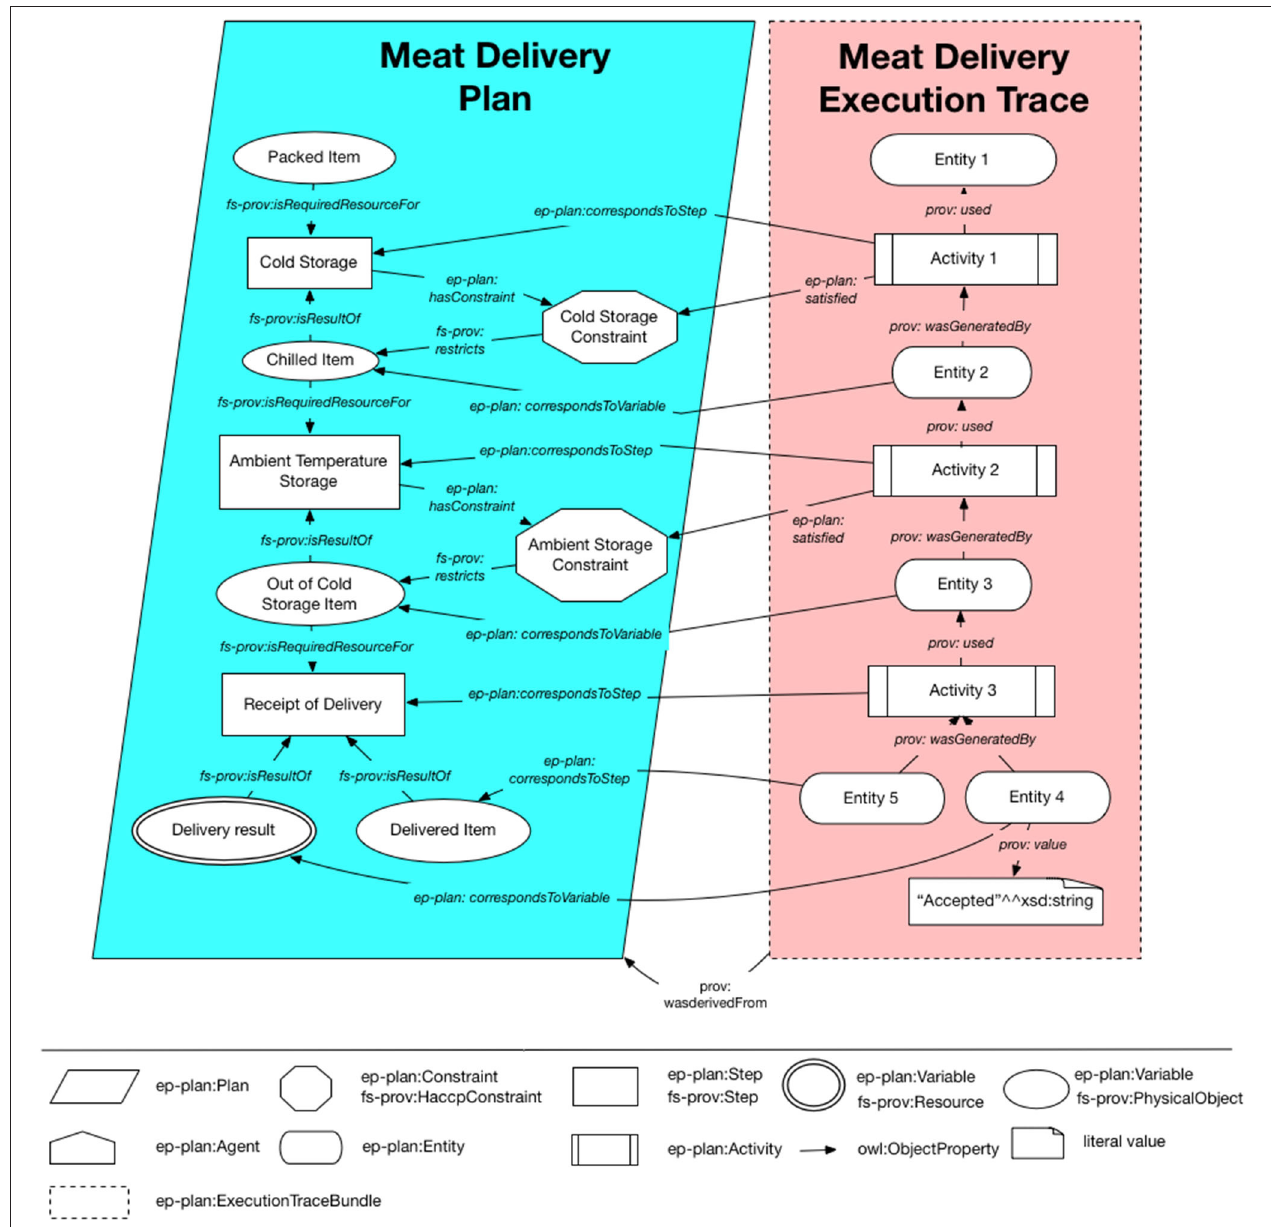
FIGURE 8 | A detailed description of a delivery plan consisting of three steps ( cold storage , ambient temperature storage , and receipt of delivery ), variables denoting the food items, associated HACCP constraints and matching execution